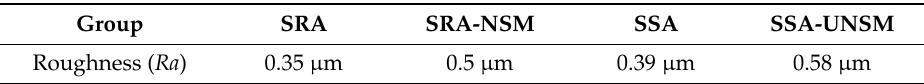
Table 3. Surface roughness of TC4 after UNSM.